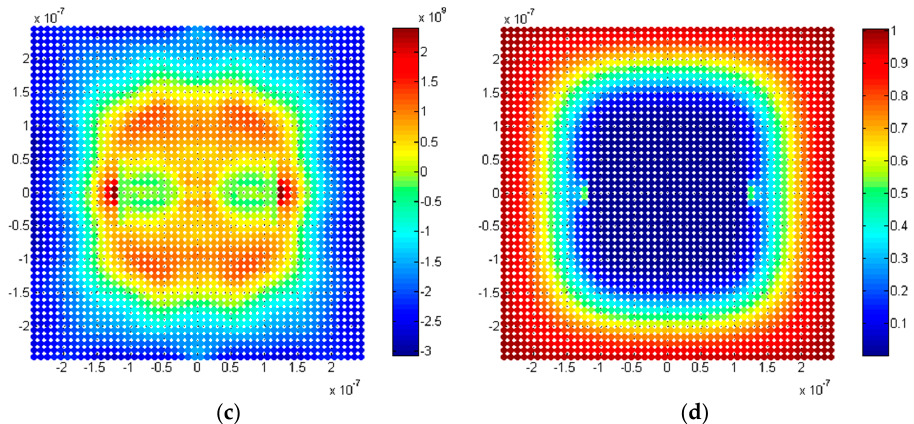
Figure 7. Result plots of the cylindrical anode with a single horizontal crack in the x - z mid-plane: ( a ) initial damage; ( b ) damage after deformation; ( c ) hydrostatic stress; and ( d ) lithium ion concentration.